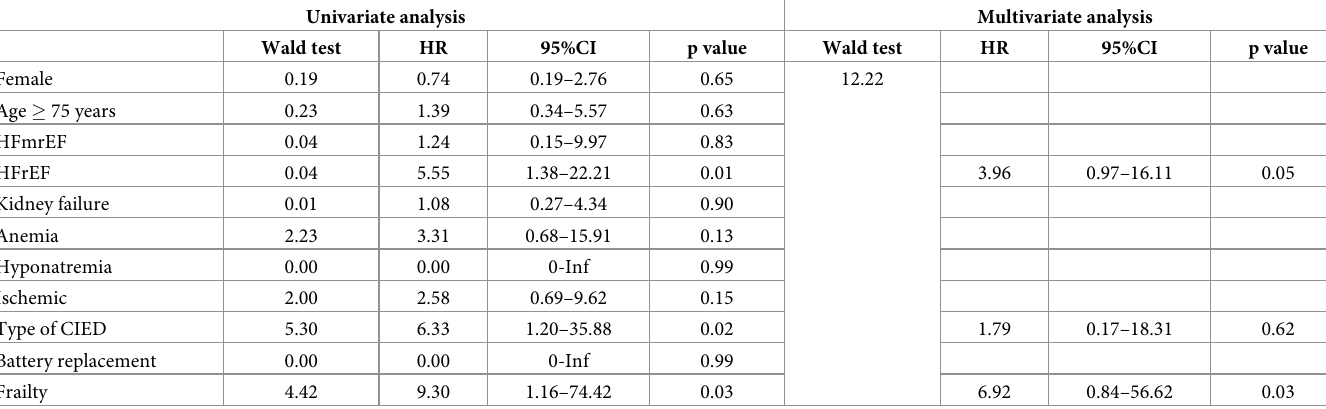
Table 3. Results of the Cox proportional hazards regression.